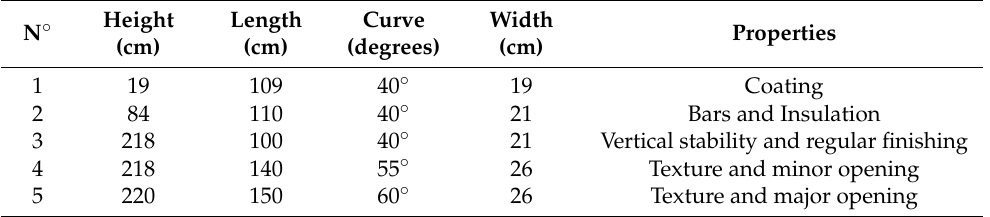
Table 4. 3D-printed wall pieces